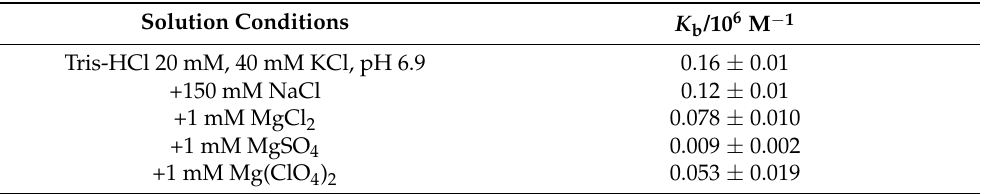
Figure 2. Binding isotherms for complex formation between tRNA and ThT obtained at the temperature of 25 °C and pressure of 1 bar in the absence ( A ) and in the presence of 1 mM of MgCl 2 ( B ), MgSO 4 ( C ), and Mg(ClO 4 ) 2 ( D ). The solid lines represent the best fit to the experimental data according to a 1:1 binding model. The binding isotherms were obtained by plotting Δ F = F − F 0 vs. total concentration of tRNA. Here, F and F 0 are the ThT fluorescence intensities in the presence and in the absence of tRNA, respectively. All the experiments were performed in 20 mM Tris-HCl buffer, 40 mM KCl, pH 6.9. Table 1. Binding constants, K b , for tRNA–ThT complex formation in 20 mM Tris-HCl buffer, 40 mM KCl, pH 6.9, in the absence and in the presence of the indicated salts at the temperature of 25 °C.